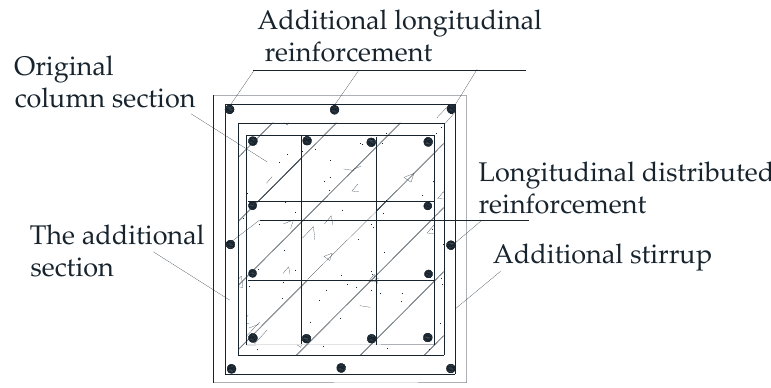
Figure 5. Enlarging the column section.